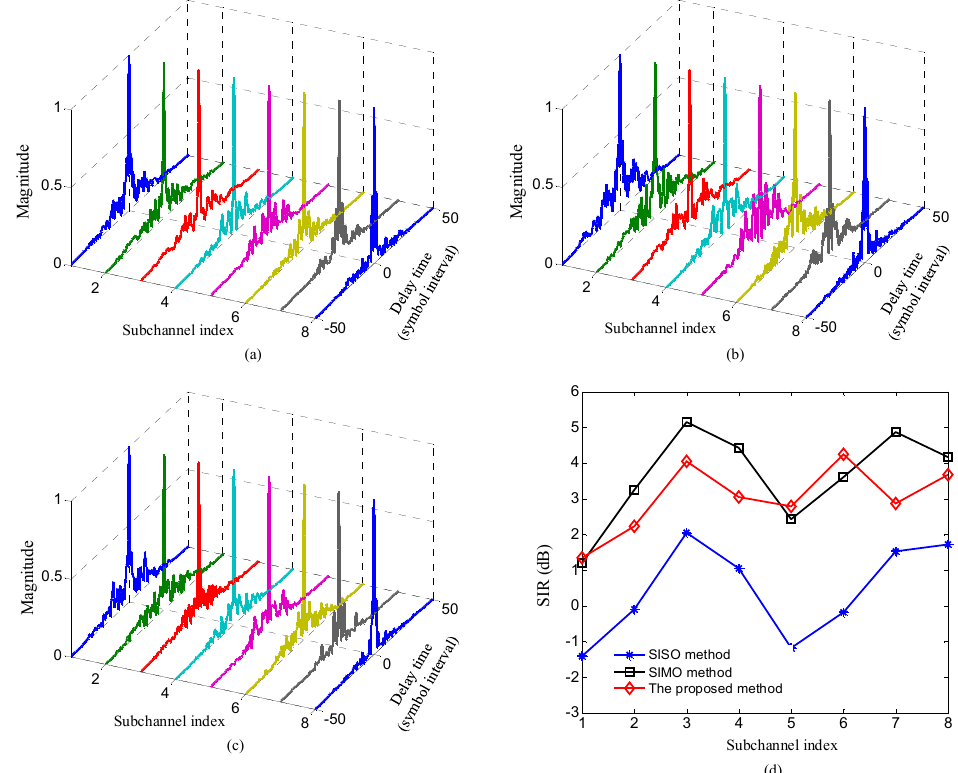
Figure 10. Comparison of the time domain responses and SIRs of composite channels in experiment among three methods: ( a ) sub-channel responses of the proposed method; ( b ) sub-channel responses of the SISO method; ( c ) sub-channel responses of the SIMO method; ( d ) SIRs of three methods.